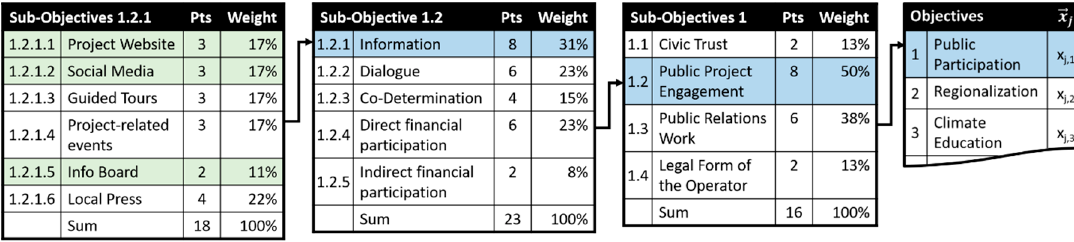
Figure 4. Exemplary breakdown of the degree of objective achievement for Public Participation.